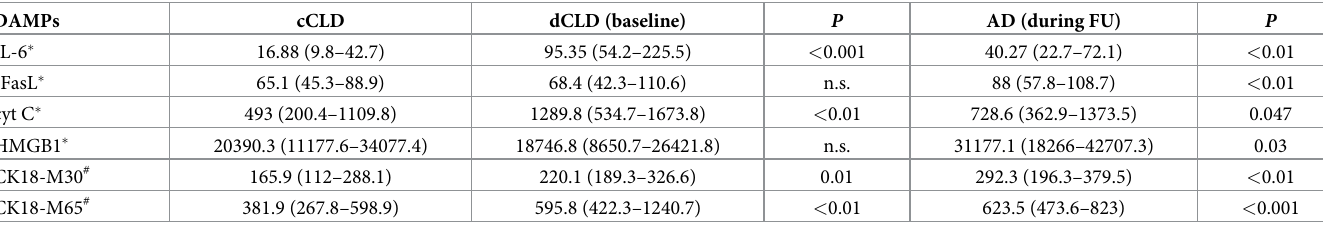
Table 3. Serum levels of DAMPs in compensated and decompensated liver disease.